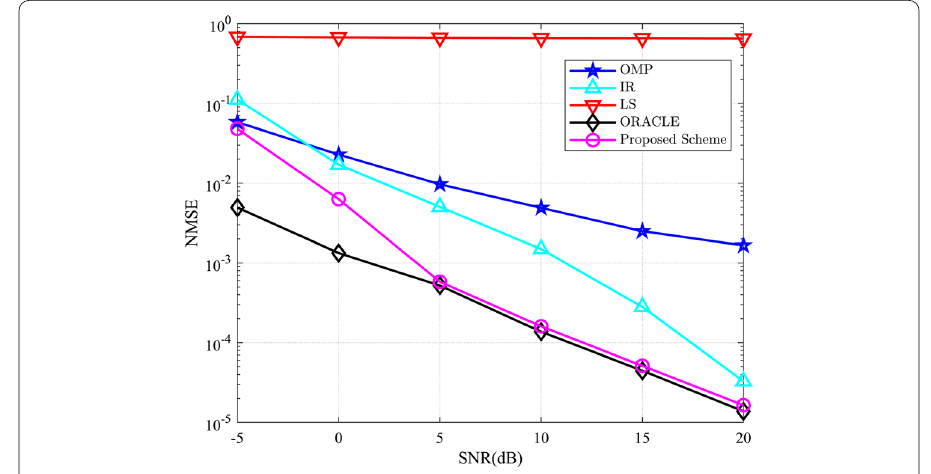
Fig. 4 NMSE performance comparison of different schemes against SNR, when N x = N y = 32 , N t = N r = 64 are considered, respectively